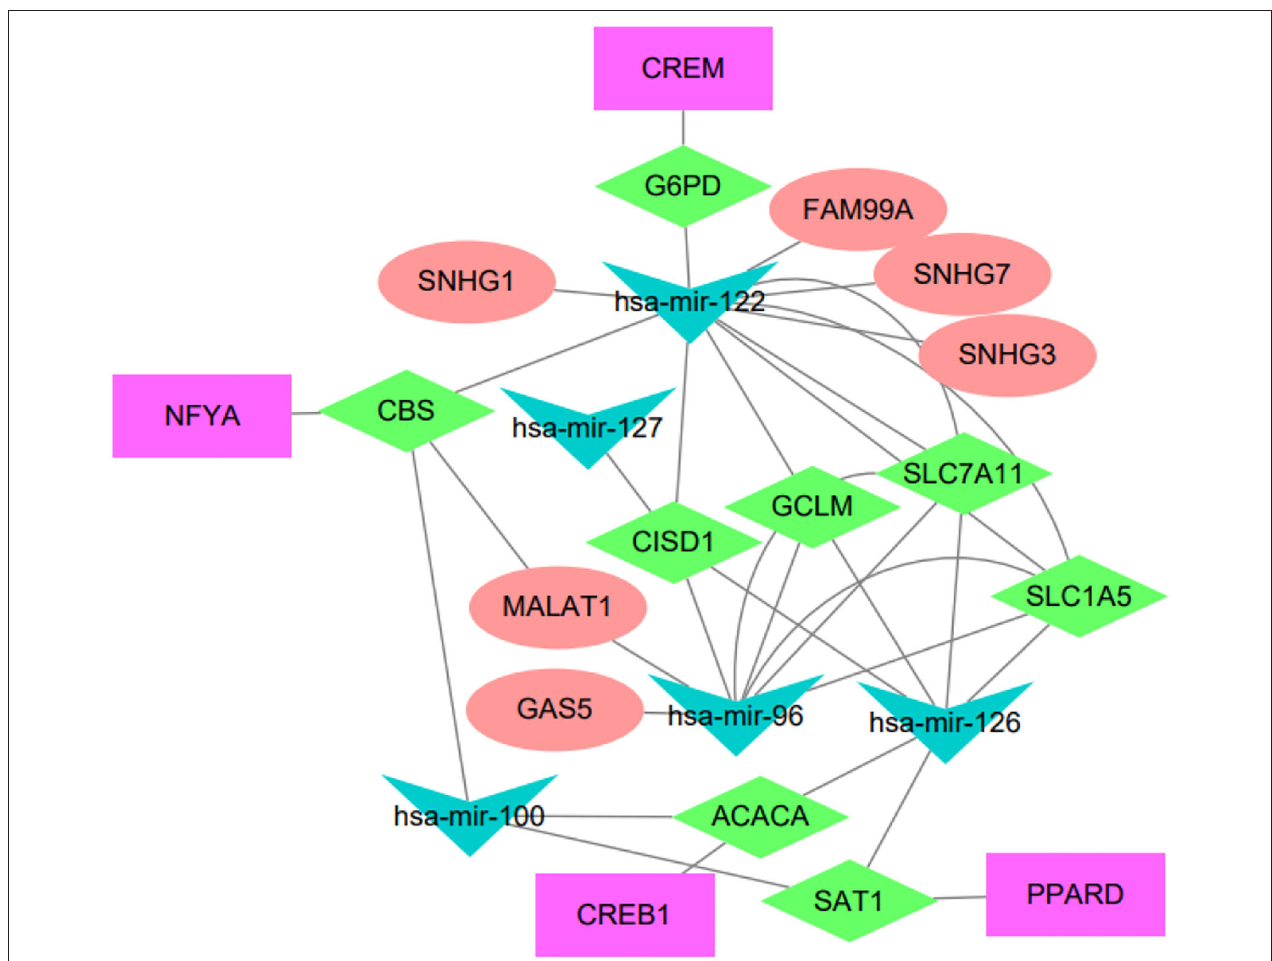
FIGURE 4 | Regulatory network of the IRGPI-related genes. The network summarizes regulation relationships between transcription factors (purple rectangles), mRNAs (green diamonds), miRNAs (blue triangles), and lncRNAs (pink